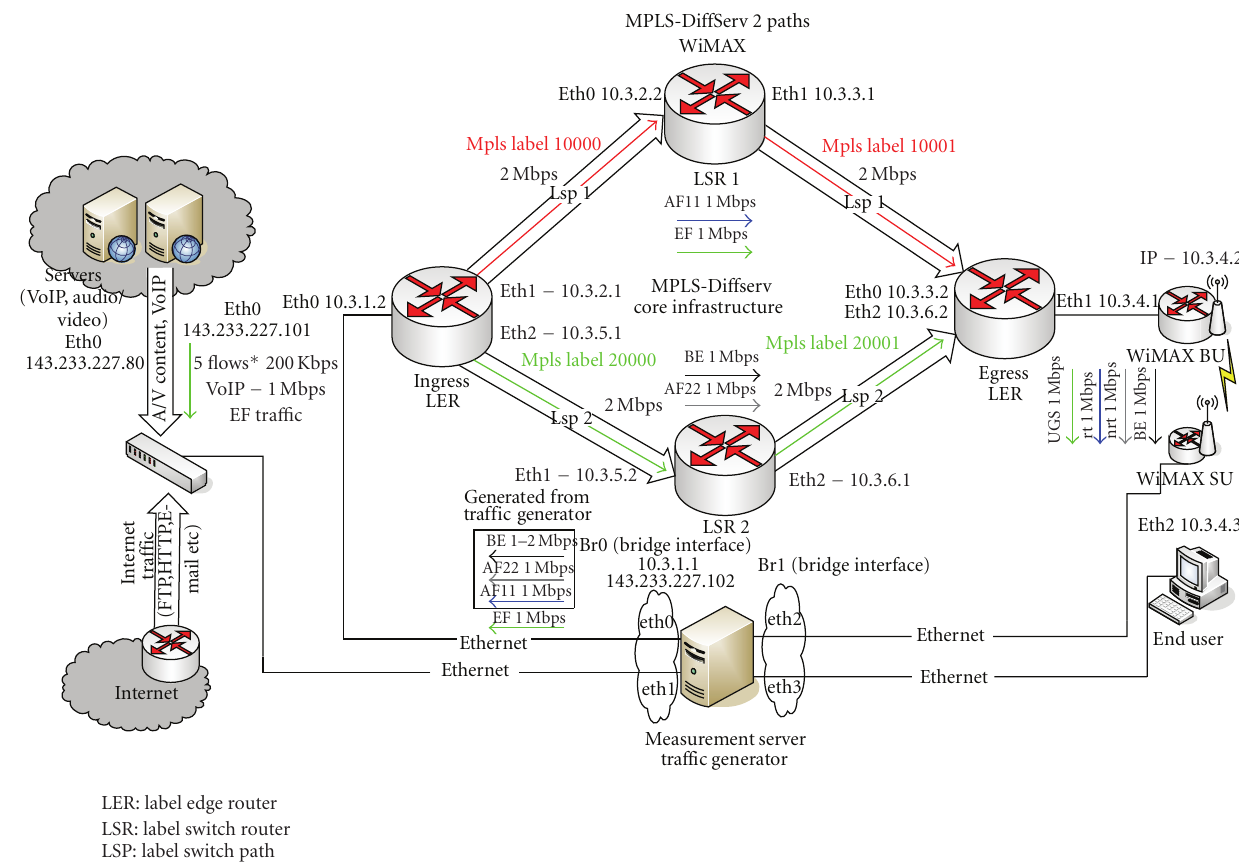
Figure 9: Core network with MPLS-Di ff Serv QoS enabled 2 paths with WiMAX access network.